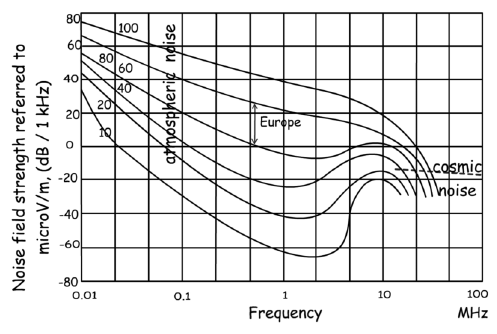
Fig. 7. Electric field strength versus frequency for atmospheric and cosmic